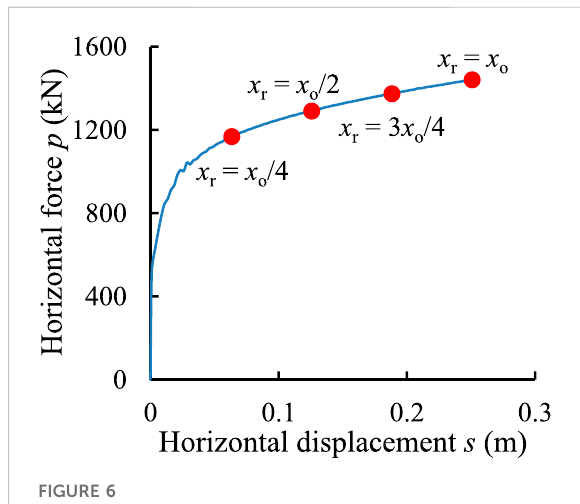
FIGURE 6 Variation of horizontal force p with horizontal displacement s at the pile top for Case